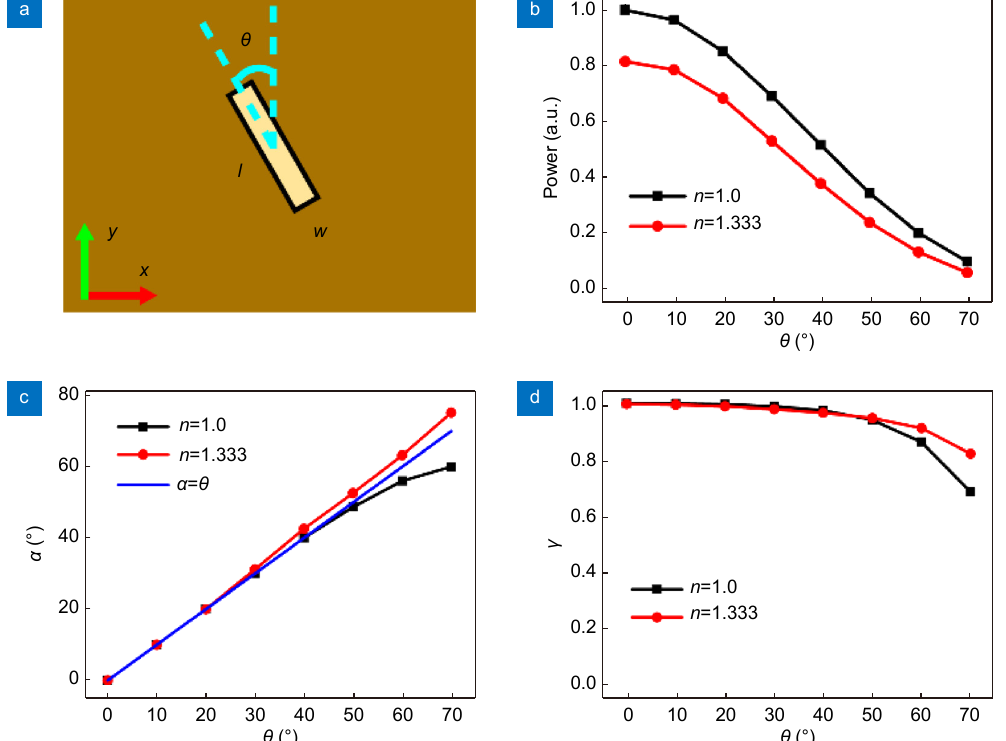
Fig. 2 | ( a ) Structure diagram and geometry parameters of a nanogroove antenna. Simulated ( b ) powers, ( c ) polarization orientation angles, and ( d ) degrees of linear polarization ( D p ) of the emission lights from one nanogroove antenna when the antenna is covered by different mediums with refractive indices of n =1.333 (red lines) and n =1.0 (black